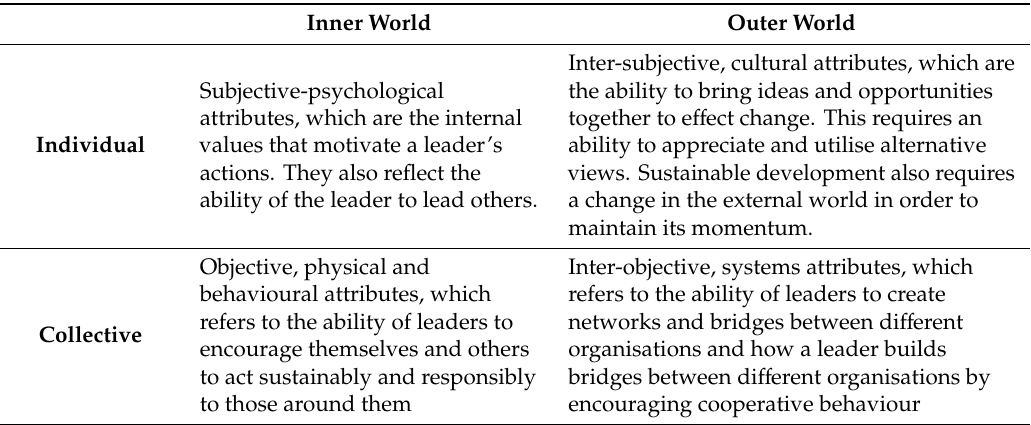
Table 1. Value-orientated